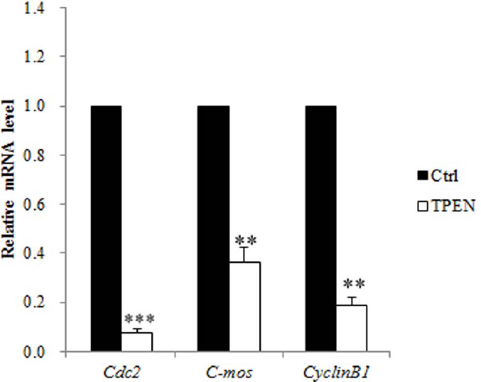
polar body was significantly higher in the control group than in the TPEN rescue group (57.59 6 6.59%, n= 75 vs. 0.00%, n= 74; P , 0.01). The maturation rate of the TPEN rescue group after 34 h